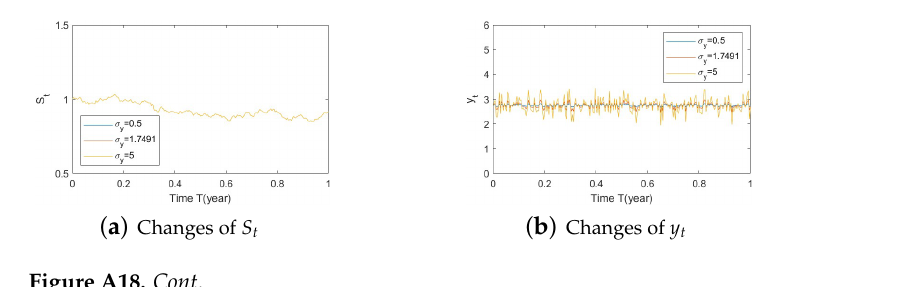
Figure A18. Cont